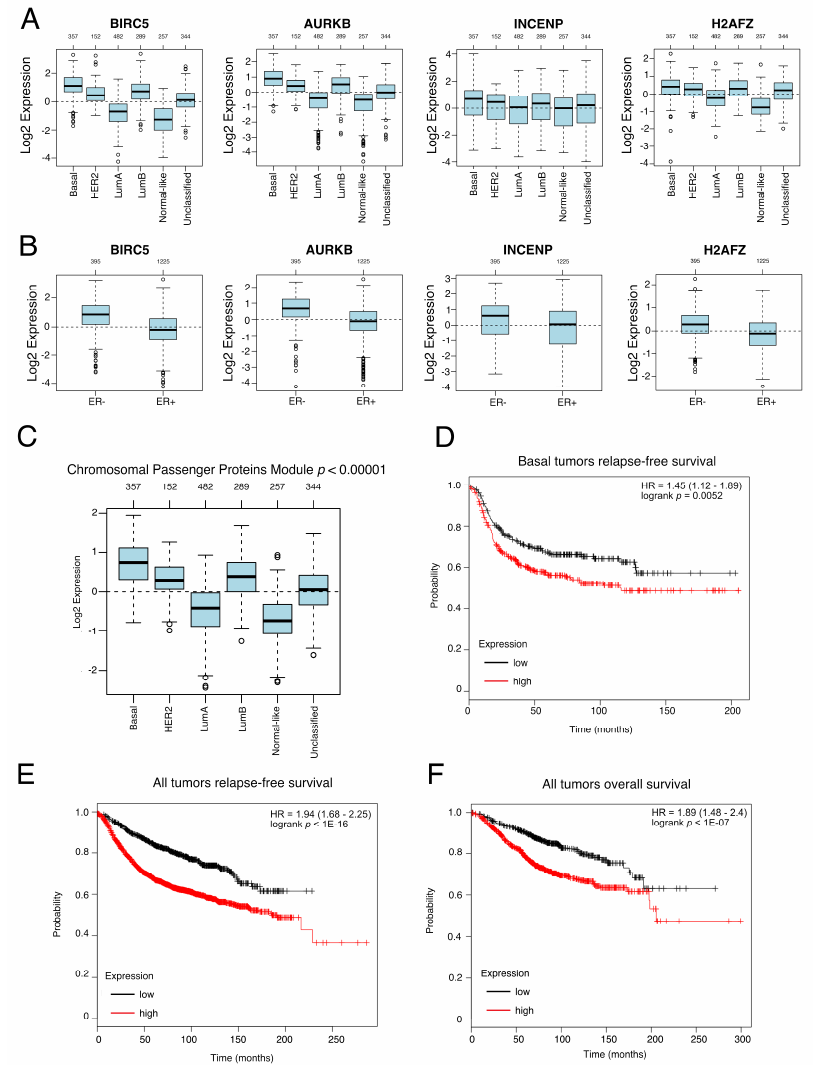
Figure 4. Clinical relevance of the CPPM in breast cancer. ( A ) Boxplot showing the normalized expression of BIRC5, AURKB, INCENP and H2AFZ in a group of 1881 breast cancer patients by breast cancer subtypes. The number of patients is shown above the plot. p < 0.00001 for all genes (ANOVA). ( B ) Boxplot showing the normalized expression of BIRC5, AURKB, INCENP and H2AFZ in a group of 1881 breast cancer patients by breast cancer ER status. The number of patients is shown above the plot. p < 0.00001 for all genes (ANOVA). ( C ) Boxplot showing normalized expression of the CPPM in a group of 1881 breast cancer patients. The number of patients is shown above the plot, p < 0.00001 (ANOVA). ( D ) Kaplan–Meier survival plot for relapse-free survival in patients with basal breast tumors derived from a published set of 249 triple-negative breast cancer patients [14], classified with the CPPM. High expression was defined as a mean expression of the module genes higher than 2093 logrank p = 0.0052, hazard ratio 1.45. ( E ) Kaplan–Meier survival plot for relapse-free survival in breast cancer patients derived from a published set of 249 triple-negative breast cancer patients [14], classified with the CPPM. High expression was defined as a mean expression of the module genes higher than 1223. logrank p = 1.10 − 16 , hazard ratio 1.94. ( F ) Kaplan–Meier survival plot for overall survival in breast cancer patients derived from a published set of 249 triple-negative breast cancer patients [14], classified with the CPPM. High expression was defined as a mean expression of the module genes higher than 1454. logrank p = 1.10 − 07 , hazard ratio